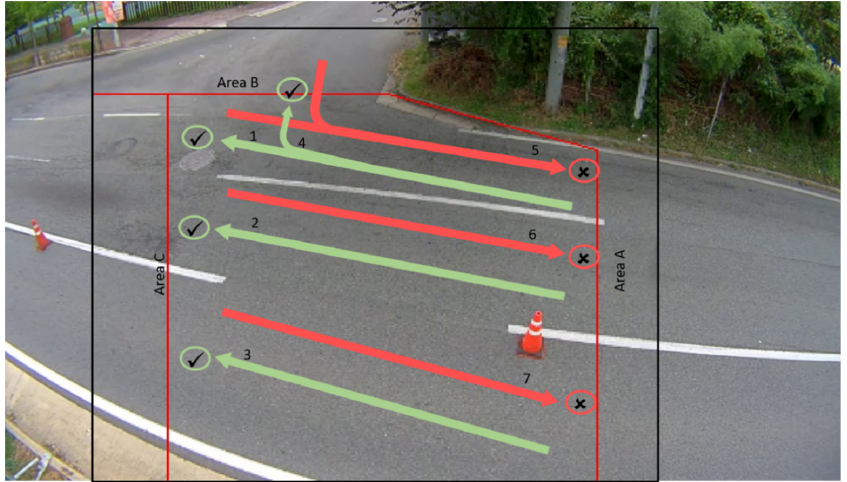
Figure 7. The entry-exit approach (black lines represent the borders of the frame).